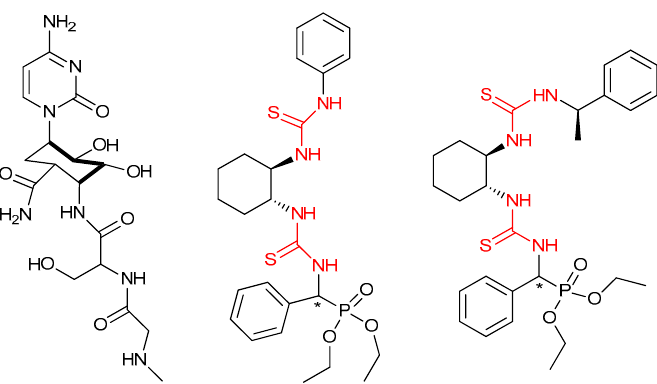
Figure 34. Ningnanmycin (left) and the most active bis-thiourea derivatives bearing α -aminophosphonate functional group [320,359].